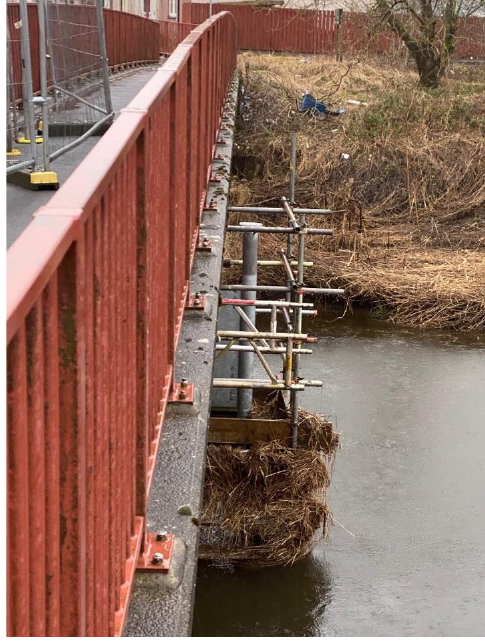
Figure 24. Hay and debris on the Probe 2.